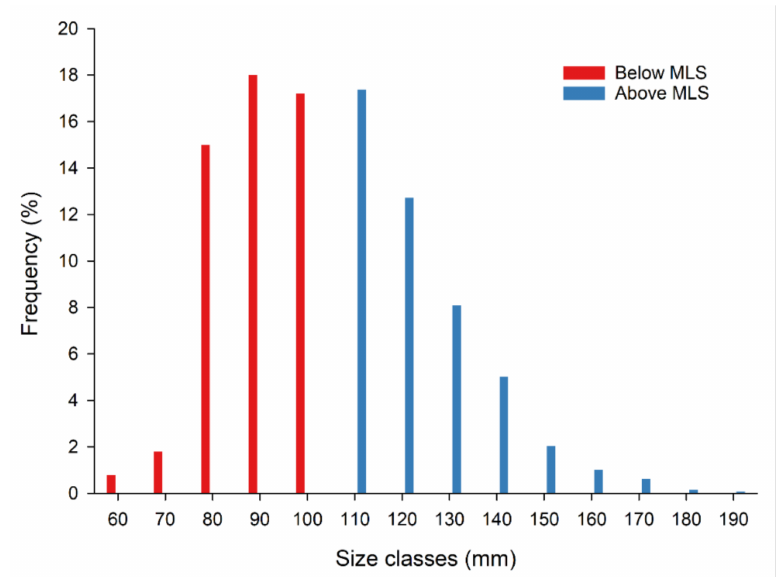
Figure 3. Carapace length (CL) size distribution of the total sample of the European lobster ( Homarus gammarus ) in relation to the minimum landing size (MLS = 105 mm CL).